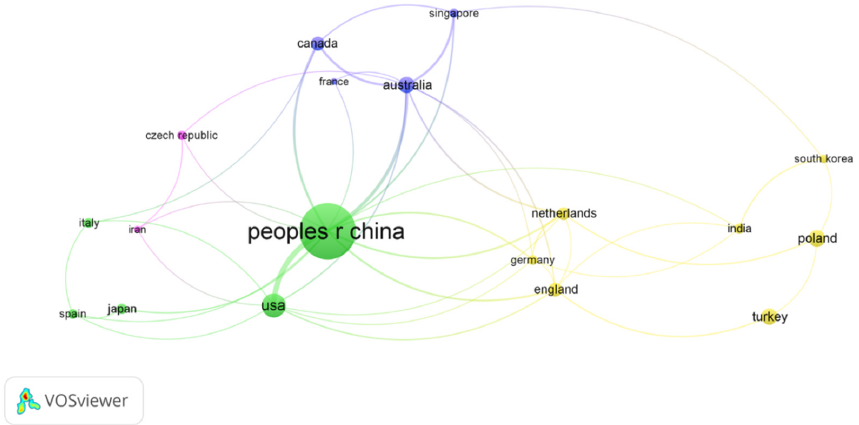
Figure 8. Country collaboration map in the field of land consolidation.